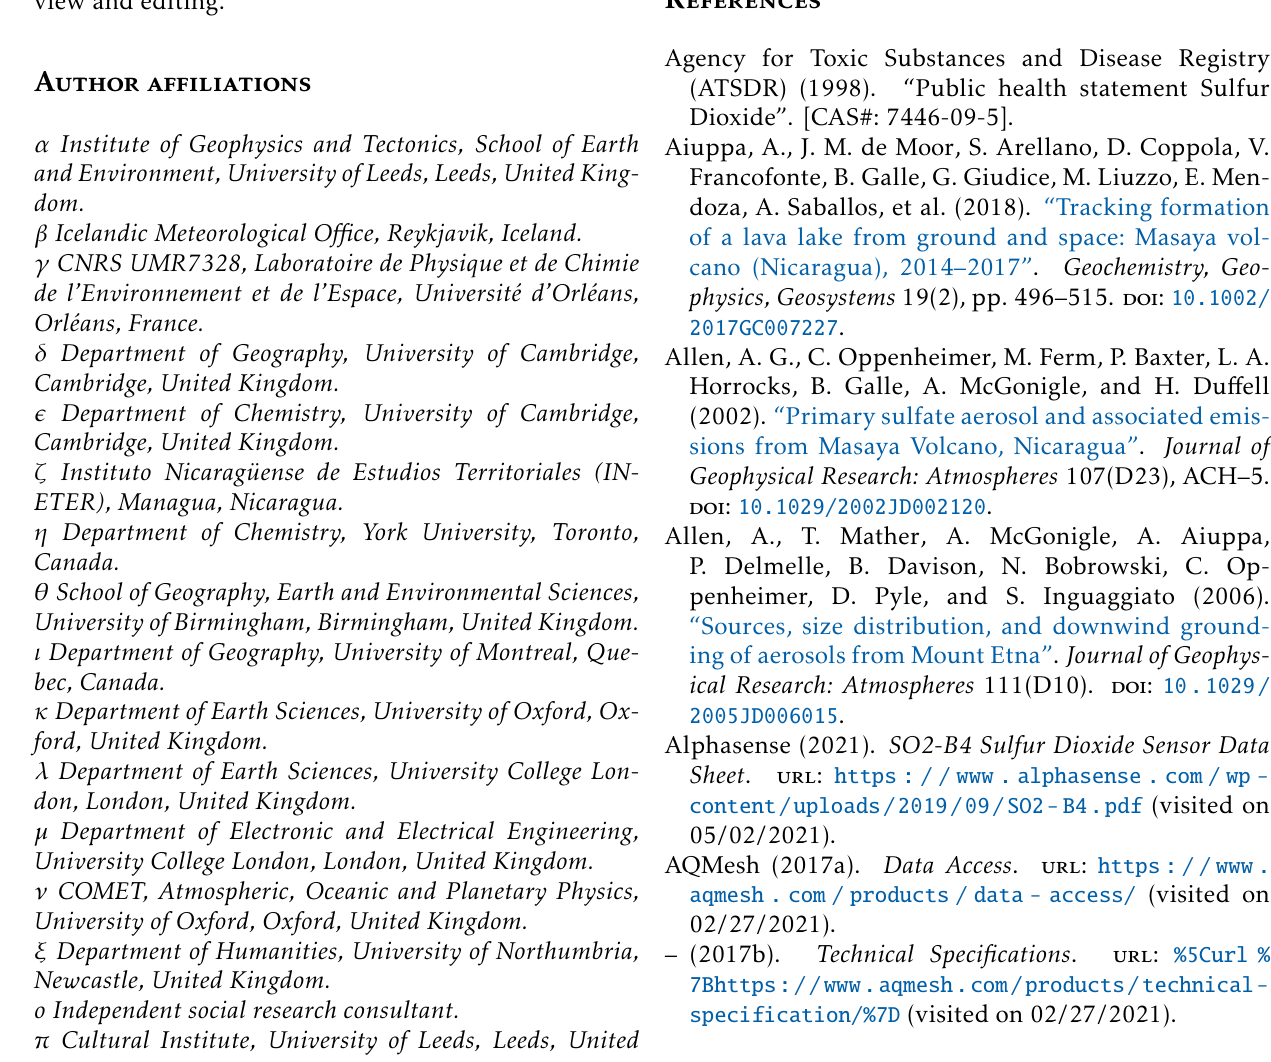
figshare at doi: 10.6084/m9.figshare.14916543